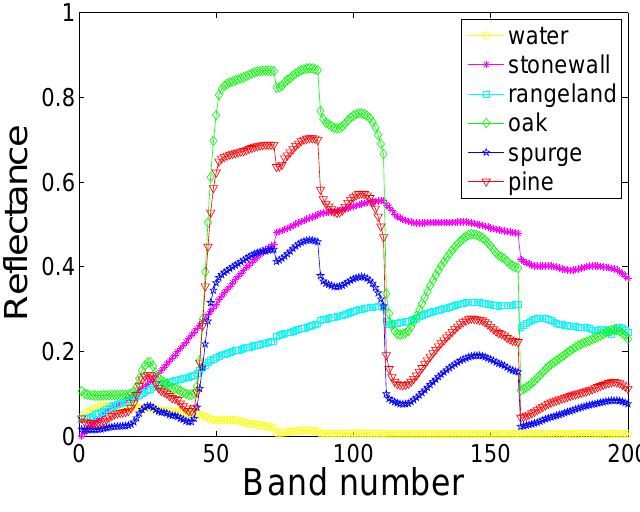
Figure 1. Six selected spectra in the